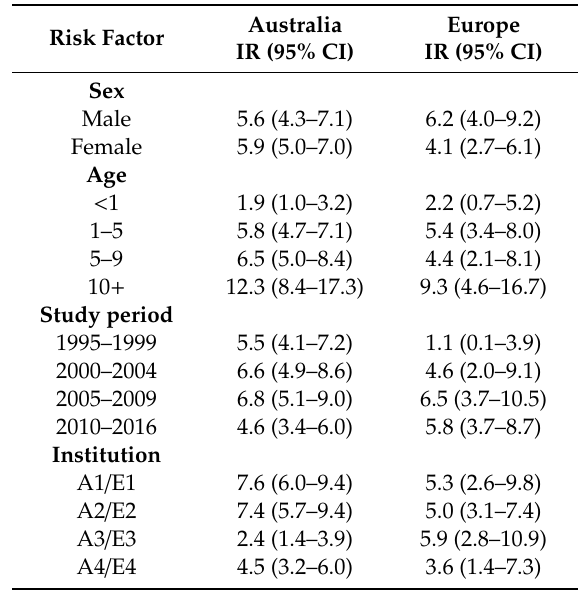
Table 2. Incidence rates (IR) (cases / 100 animal years) and 95% confidence intervals (CI) for MPPD by sex, age group, study period and institution, for macropods housed at eight Australian and European institutions between 1 January 1995 and 28 November 2016.